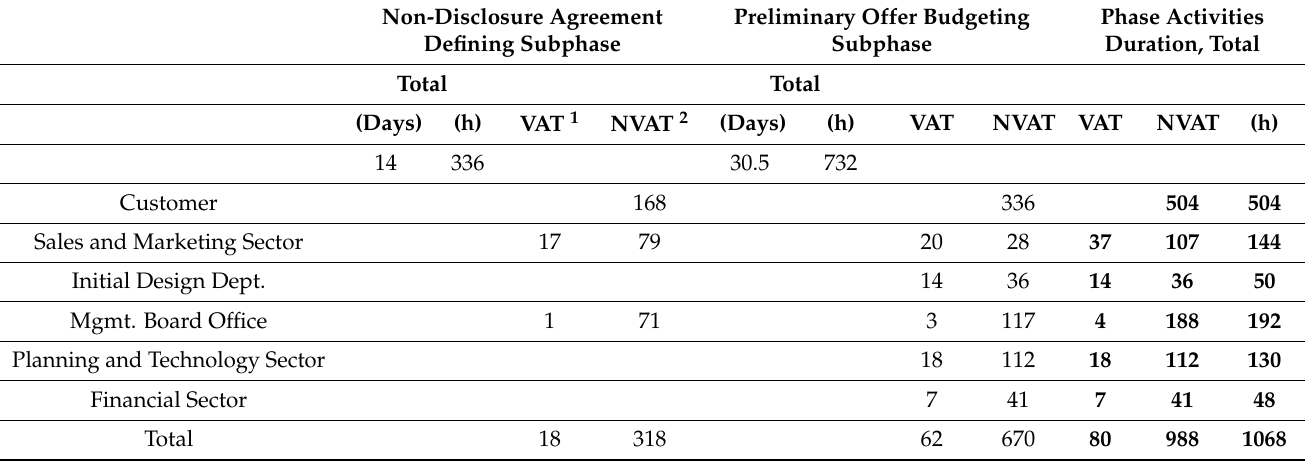
Table A7. The average durations of the Preliminary offer preparation phase activities—the future